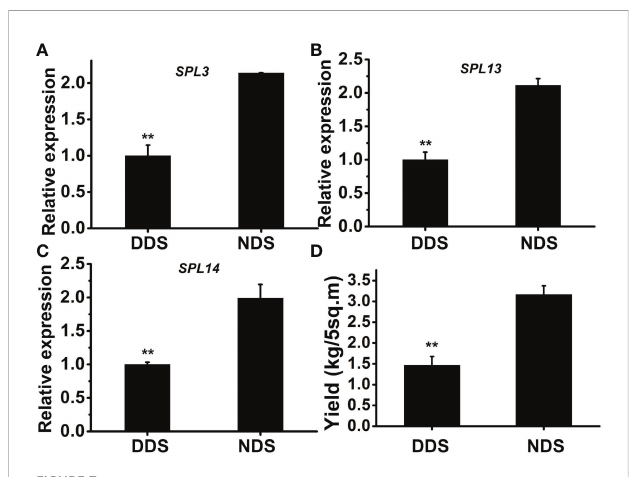
FIGURE 7 The theoretical yield was reduced in DDS plants. (A-C) A qRT-PCR analysis of temporal expression in the whole plant containing SPL3, SPL13, SPL14 genes. (D) The theoretical yields were estimated. Data represent the mean ± SD of three biological replicates (Student ’ s t test: **P ≤ 0.01).